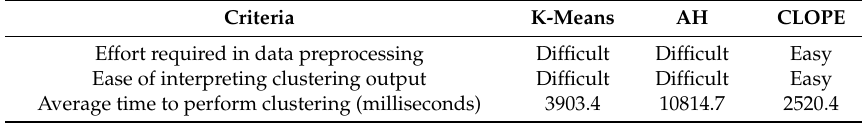
Table 3. Performance comparison of K-means, agglomerative hierarchical (AH), and CLOPE, Criteria = performance criterion.